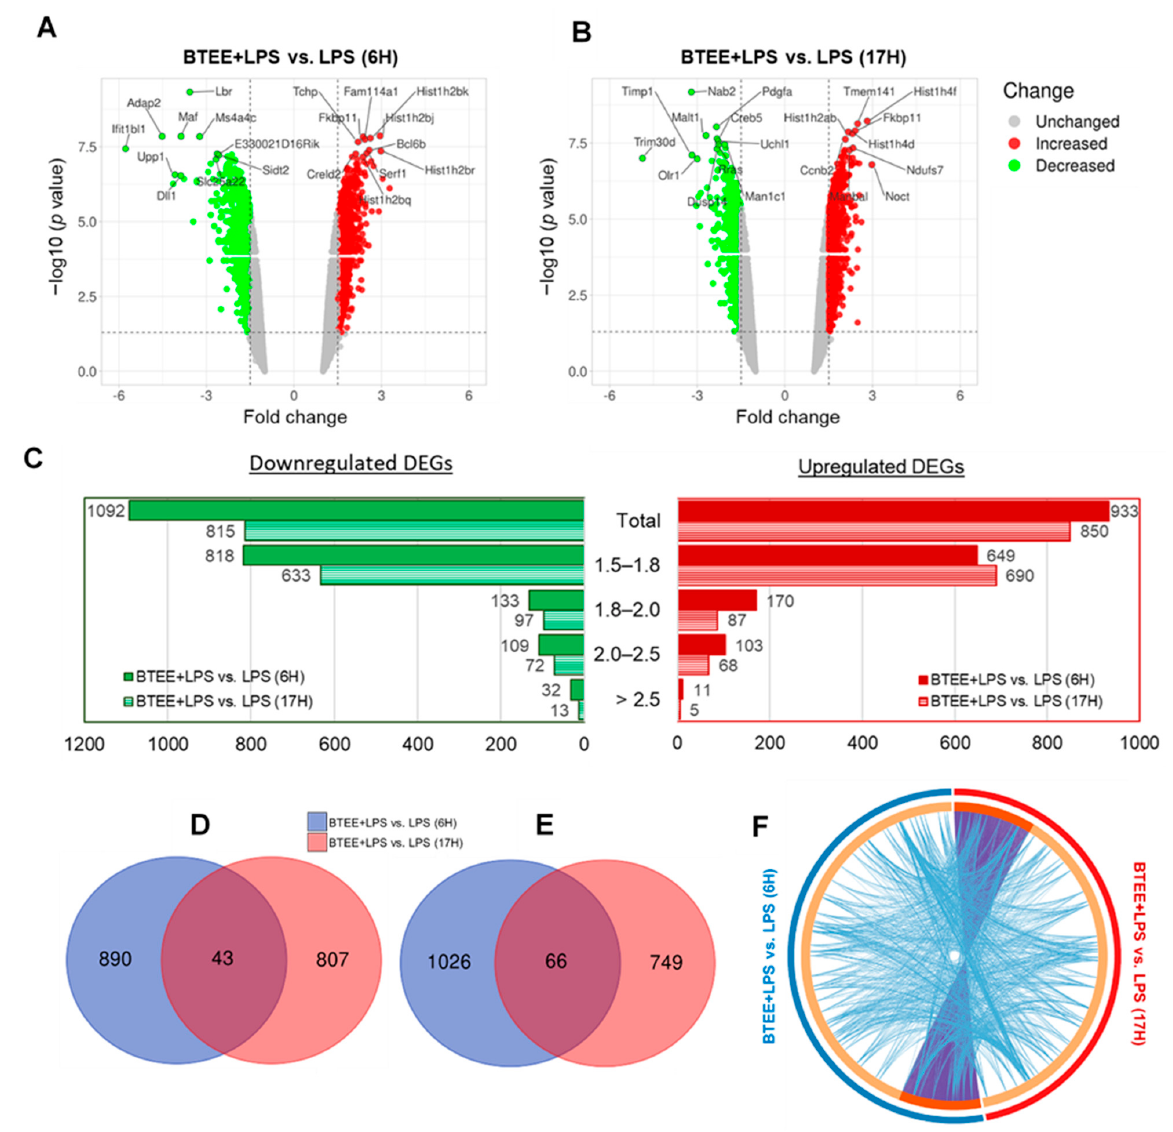
Figure 4. Characterization of gene expression profile in BTEE-treated RAW264 cells. Volcano plots displaying differentially expressed genes (DEGs) between BTEE-treated and nontreated RAW264 cells ( A ) 6 h after LPS induction and ( B ) 17 h after LPS induction. The vertical axis (y-axis) corresponds to − log10 p value and the horizontal axis (x-axis) displays linear fold change. The red dots represent the upregulated genes; the green dots represent the downregulated genes. The top 20 DEGs with the biggest fold changes are shown. ( C ) Bar graphs showing the distribution of fold changes of the DEGs in BTEE-treated RAW264 cells. The red bars (red fi ll bars refer to 6 h and pa tt ern bars refer to 17-h condition) represent the numbers of upregulated DEGs; the green bars represent the numbers of downregulated genes (green fi ll and pa tt ern bars refer to 6 h and 17-h conditions, respectively). Venn diagrams illustrate gene expression similarity between two experimental conditions in RAW264 cells. Blue circles represent DEGs between BTEE + LPS vs. LPS 6 h and red circles represent BTEE + LPS vs. LPS 17-h conditions; ( D ) Upregulated DEGs and ( E ) Downregulated DEGs. ( F ) The Circos plot shows how genes overlap between 6 h and 17-h conditions. On the outside, the blue arc represents the DEG list from BTEE + LPS vs. LPS 6 h and the red arc represents the DEG list from BTEE + LPS vs. LPS 17-h condition. On the inside, the dark orange color represents the DEGs shared by both 6-h and 17-h conditions and the light orange color represents the DEGs unique to each condition. Purple lines link the common DEGs shared by both conditions. Blue lines connect the DEGs that fall under the same signi fi cantly enriched gene ontology term.